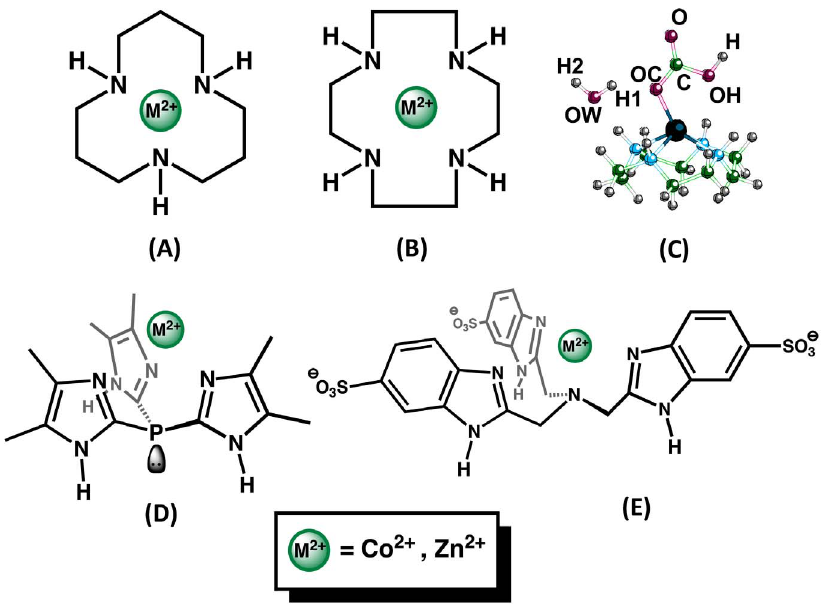
Figure 1. Molecular structures of 1,5,9-triazacyclododedacane (A) and 1,4,7,10-tetraazacyclododedacane (B) which are denoted N3 and N4 in the text, respectively. Panel (C) shows how the atoms are denoted in the text. The structures of tris(4,5-dimethyl-2- imidazolyl)phosphine (D) and tris(2-benzimidazlylmethyl)amine (E) are denoted Ph and Ben in the text, respectively.